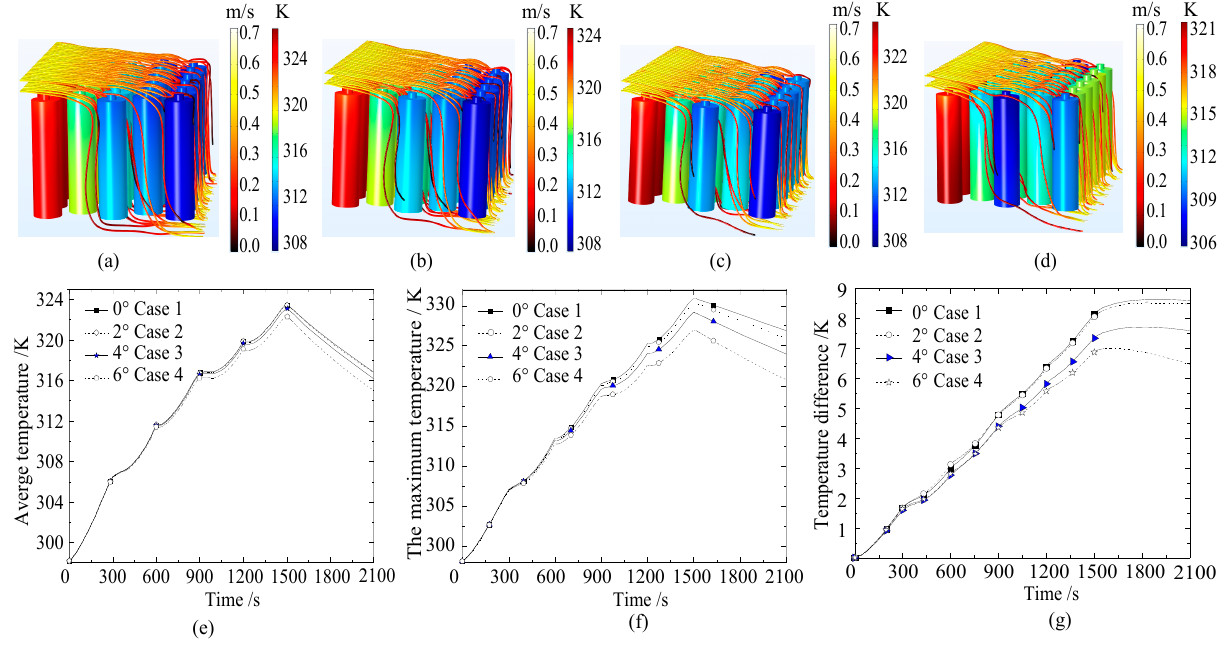
Figure 5. Thermal characteristic analysis ( a ) cloud chart of air streamline and battery temperature α = 0 ◦ ; ( b ) cloud chart of air streamline and battery temperature α = 2 ◦ ; ( c ) cloud chart of air streamline and battery temperature α = 4 ◦ ; ( d ) cloud chart of air streamline and battery temperature α = 6 ◦ ; ( e ) relationship between the average temperature and time; ( f ) relationship between the maximum temperature and time; and ( g ) temperature di ff erence versus time.